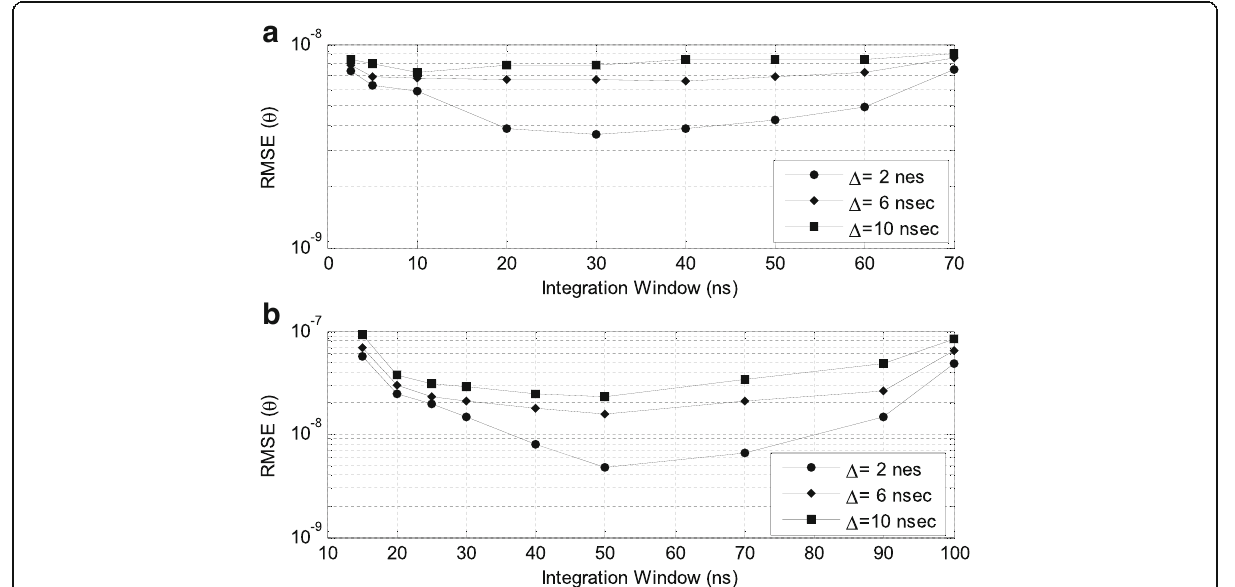
Fig. 7 RMSE of TD energy detection estimator vs. integration window length Tint, for various integrating step Δ , SNR = − 10 dB, a LOS case b NLOS case